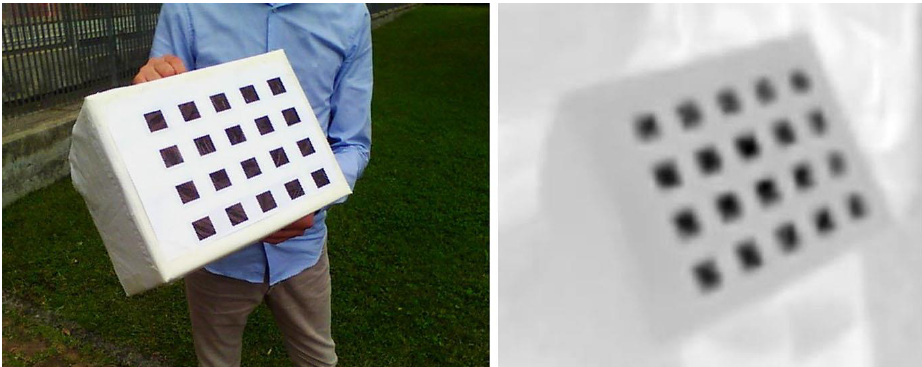
Figure 4. The target recorded in the visible (left) and in the thermal bands (right) in a single Figure4. Thetargetrecordedinthevisible(left)andinthethermalbands(right)inasinglemeasurement. measurement.